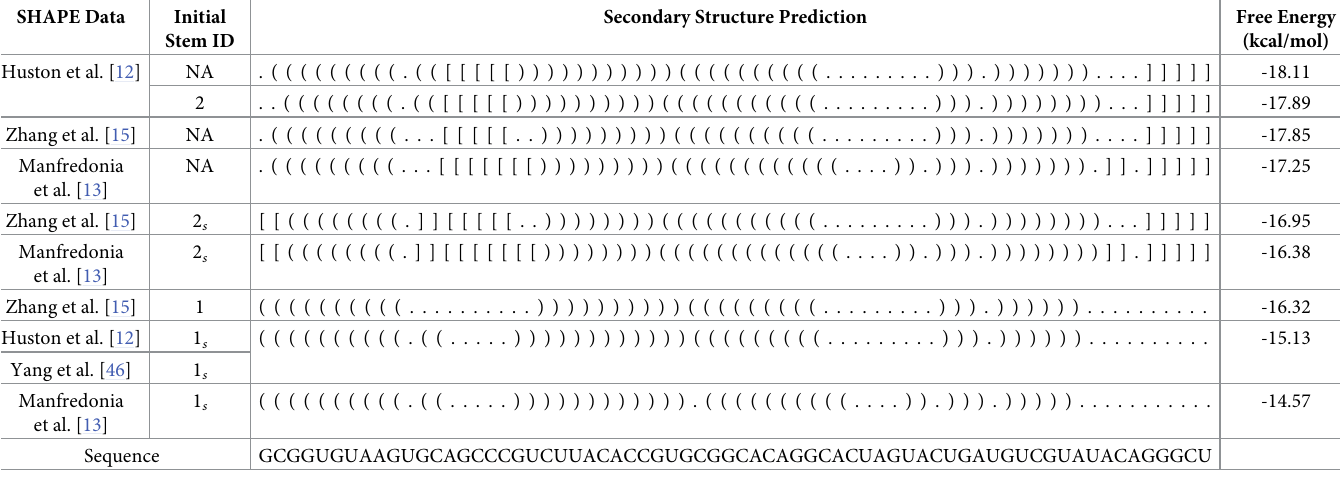
Table 9. Most energetically favourable ShapeKnots [44] secondary structure predictions for the SARS-CoV-2 − 1 PRF stimulating pseudoknot based on the reference sequence. SHAPE dataset source for each prediction indicated in the first column. Second column provides stem IDs, NA if none used. Certain suboptimal structures (e.g., 2 ) are reported because of only slightly higher free energy than the minimum free energy structure predicted by s